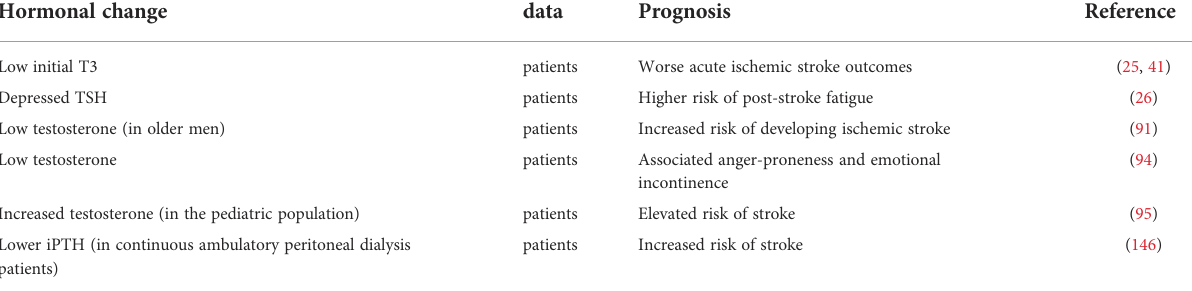
TABLE 1 Effect of hormone changes on the prognosis of ischemic